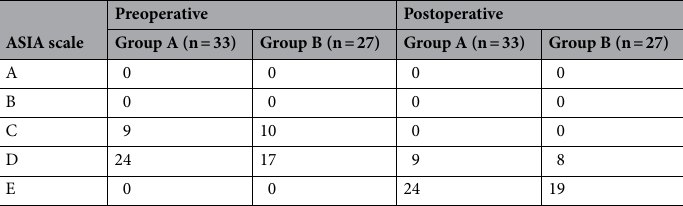
Table 3. Comparison of neurological status between the two